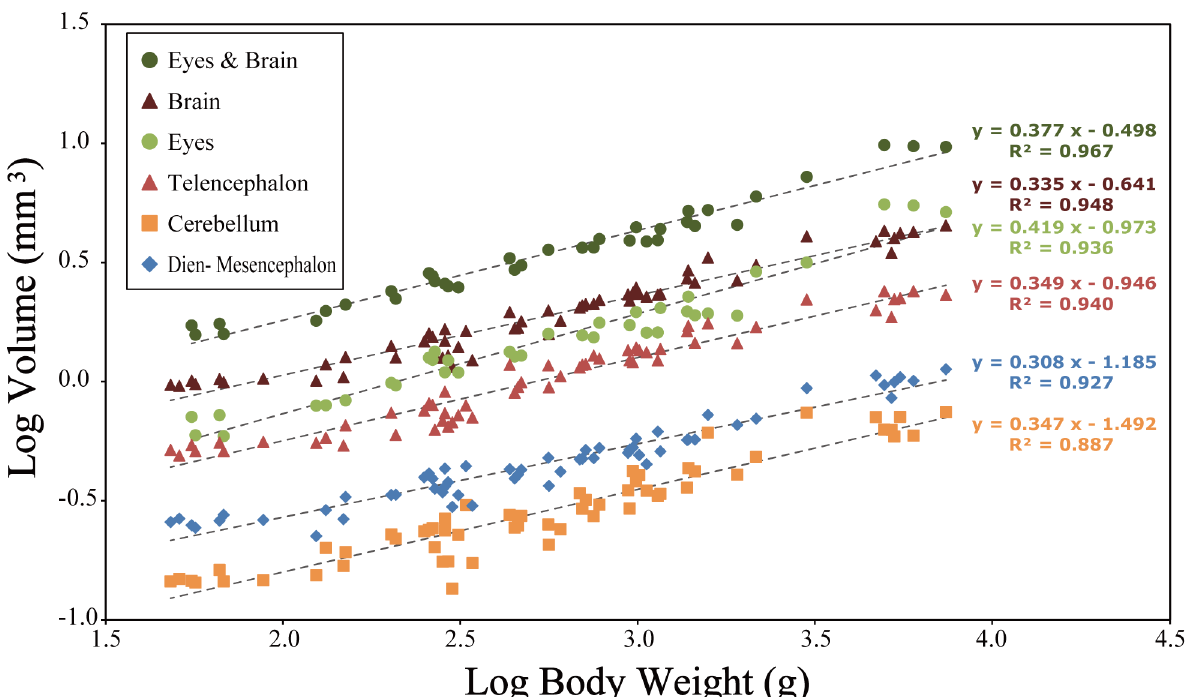
Fig 7. Relationship between body weight and eyes + brain (dark green circles), whole brain volume (brown triangles), eyes (light green circles), and brain regions (telencephalon, red triangles; cerebellum, yellow squares; diencephalon and mesencephalon, blue